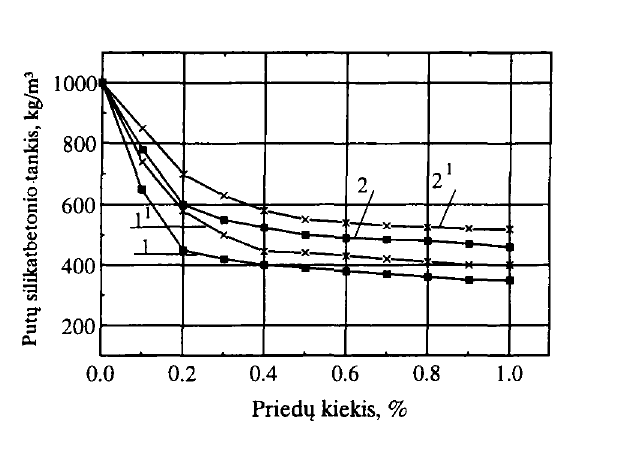
Fig 4. Foam silicate concrete dependency on surface active materials amount and mixing method: 1 - Sulphanol; 2 - OP- 10;1,2 - All the components mixed together; 1 1 , z! - Sand slime mixed with surface active material and later with other solid mixture components